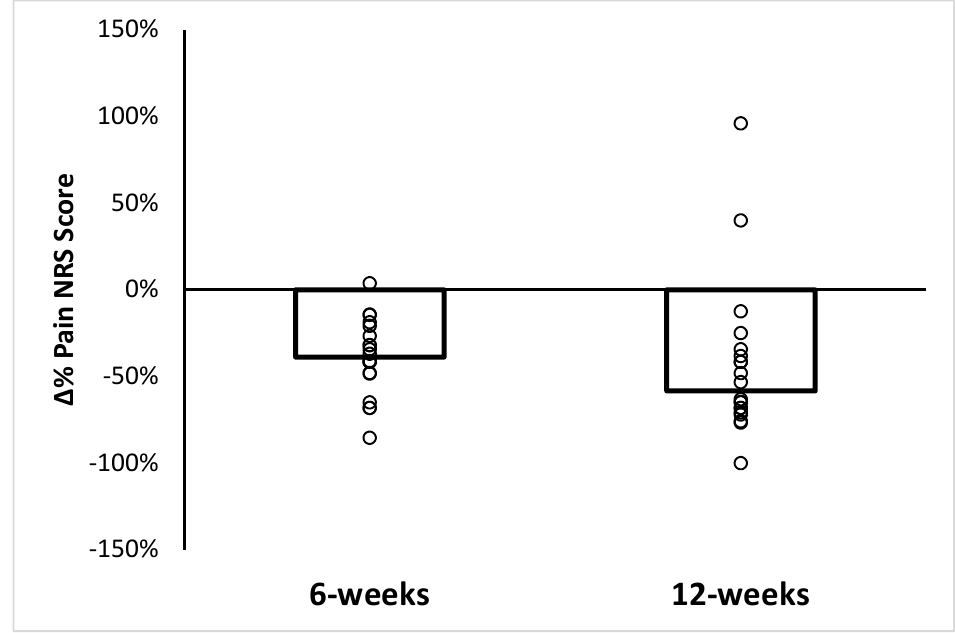
Figure 3. Individual and mean (week 6) or median (week 12) relative percentage in pain score. Eighteen out of 20 participants would recommend the intervention to someone else with their condition. Twelve of the participants were running at least 5 km twice weekly, in shoes and on the road at the 12-week point. One participant continued to run barefoot on the grass at the 12-week point.